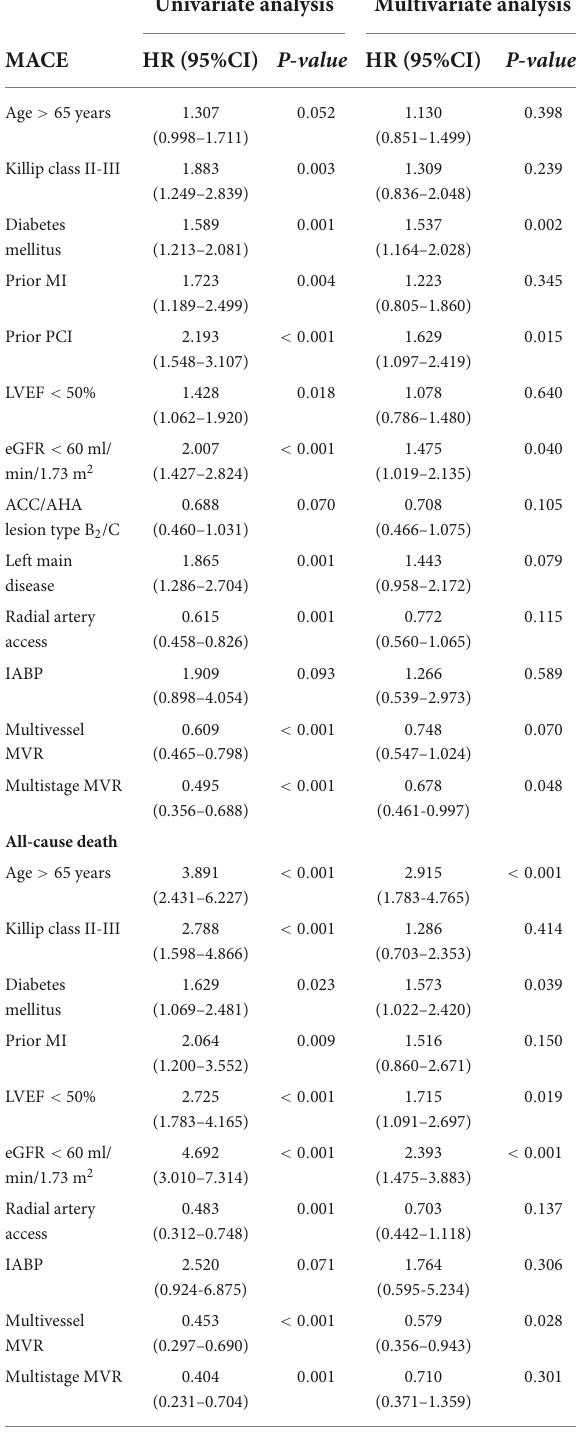
TABLE 4 Independent predictors of clinical